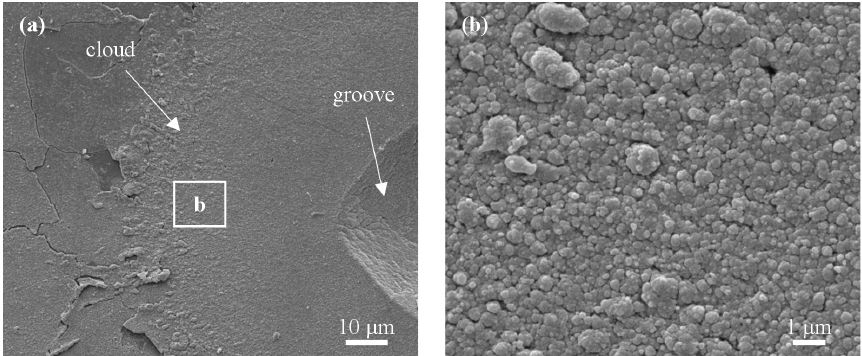
Figure 6. SEM image of the dark cloud found around the groove on the upper surface of the HPHT sample, machined by a fluence of 10.3 J/cm 2 ; ( a ) the entire cloud and ( b ) in detail.